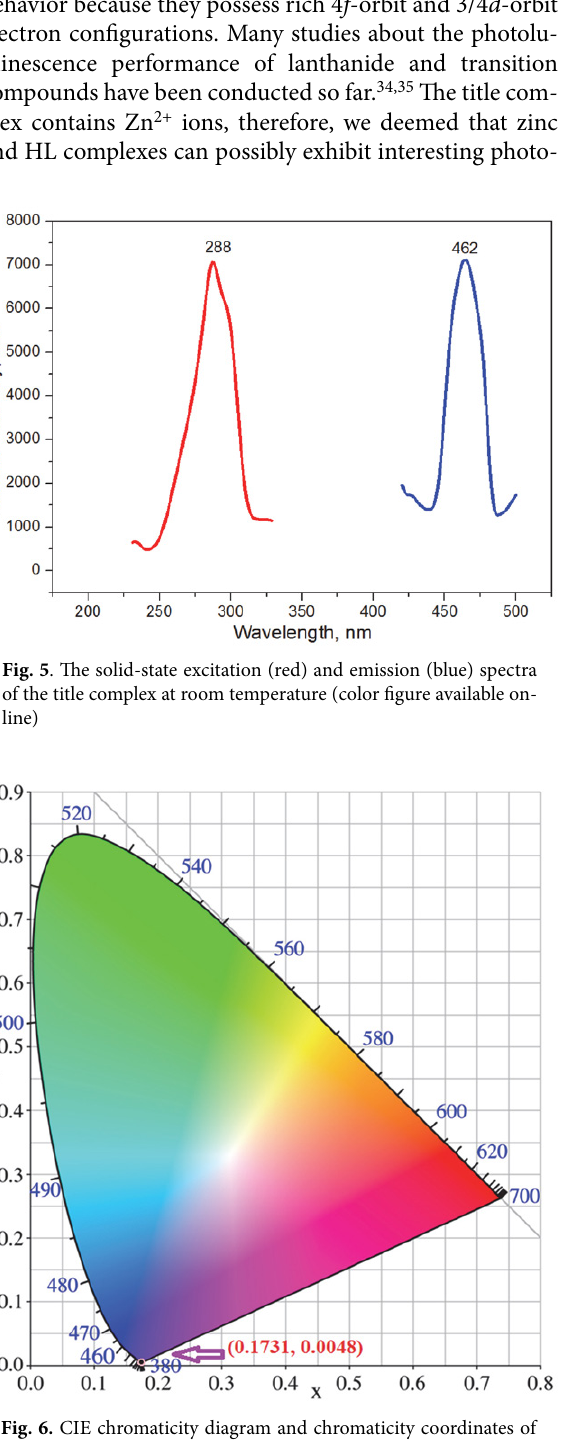
Fig. 6. CIE chromaticity diagram and chromaticity coordinates of the emission spectrum of the title complex